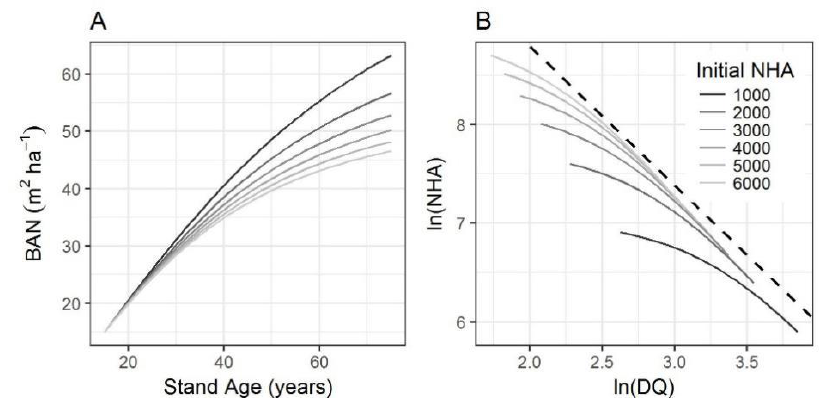
Figure 6. Model projections of 60 years of basal area of Nothofagus species (BAN, Equations (3) and (9)) with a different initial number of trees per hectare (NHA). Projections are based on an initial BAN of 15 m 2 ha − 1 , the dominant age of 15 years, SI of 10 m, and PBAN of 1. ( A ) Dominant age vs. BAN trajectories. ( B ) DQ vs. NHA trajectories. The dashed line is the DQ max line for N. alpina.